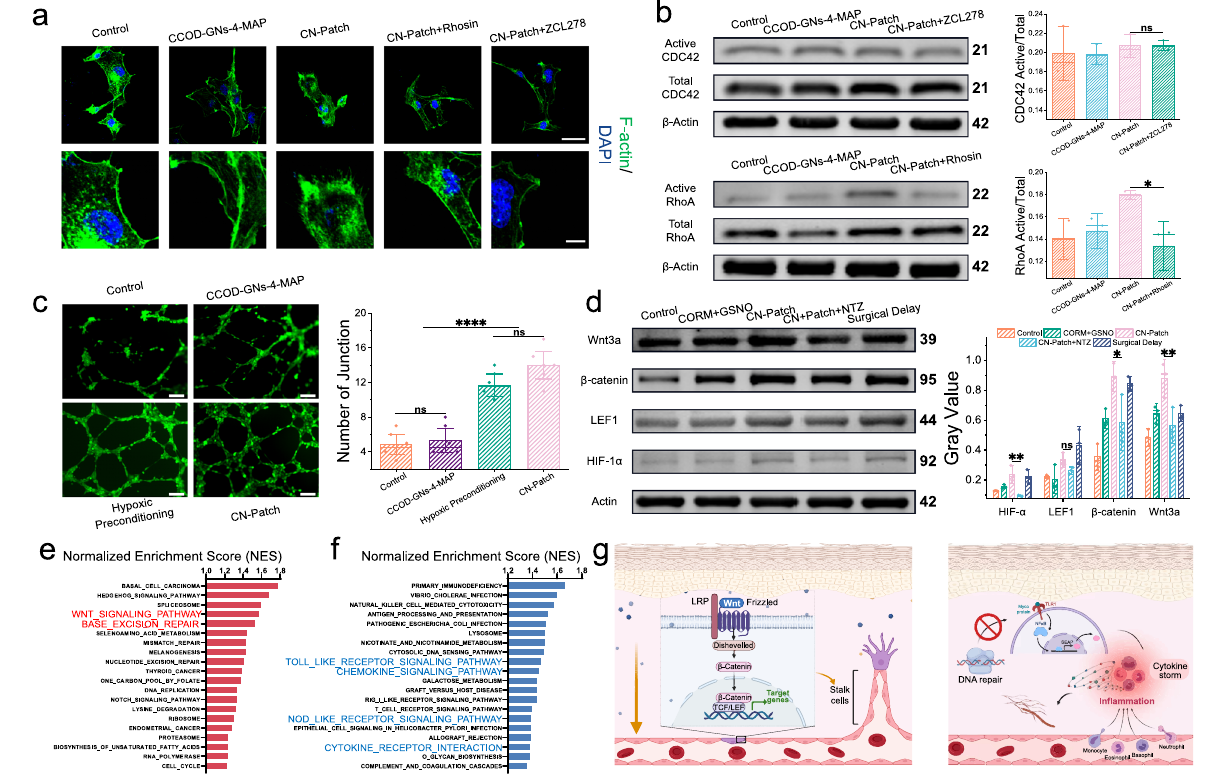
Fig. 6 | The CN-Patch improvestransplant survivalby promoting angiogenesis andreducingin fl ammatoryresponses.a TheCN-PatchincreasedtheF-actinlevel ofHUVECs,butthisprocesswasweakenedbyRhosinandZCL278.Scalebar:40 µ m, 10 µ m from top to bottom ( n =6). b The Pull-down technology was used to detect the activation of Rho GTPase by CN-Patch. The CN-Patch has a signi fi cantly acti- vating effect on RhoA-22kDa, but not on CDC42-21kDa (mean±SEM, n =3 inde- pendent samples per group). c The angiogenesis experiment: Compared to the control group, the CN-Patch promoted HUVECs vascular formation in vitro, which was consistent with the hypoxic preconditioning group. Scale bar: 100 µ m (mean±SEM, n =6 independent samples per group). d The Western Blot analysis showed that the expression of Wnt/ β -catenin pathway-related proteins in the skin fl apincreased on7thdayaftertransplantation in rats.Aftertreatment withthe CN-